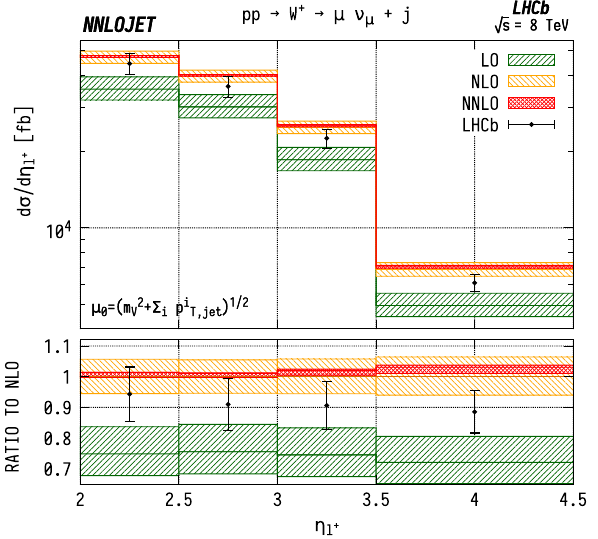
Fig. 10 Cross section differential in the pseudorapidity η of the lepton for W + J production. See Fig. 3 for details